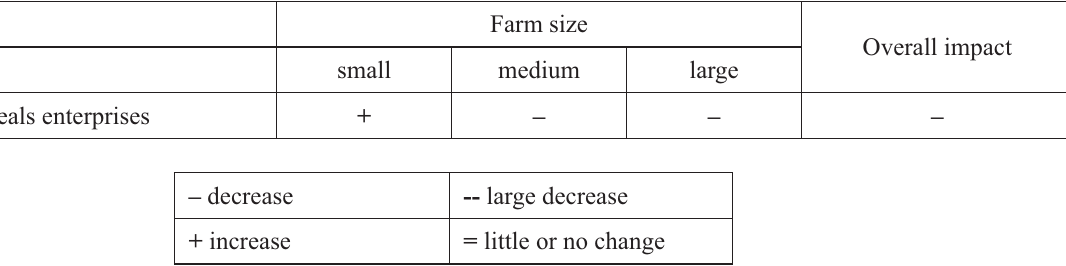
Table 3. Summary of impacts of changes in CAP subsidy support payments on change in land use for cereal farms according to farm size (defi ned by ESU units) in England in 2012 compared with the baseline period of 2000/02